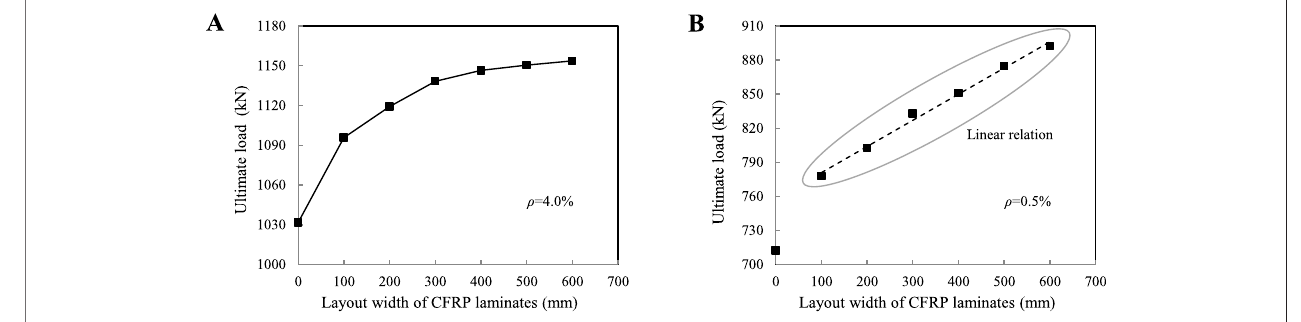
FIGURE 12 | Curve of the ultimate load varied with CFRP width: (A) reinforcement ratio ρ = 4.0%; (B) reinforcement ratio ρ = 0.5%.